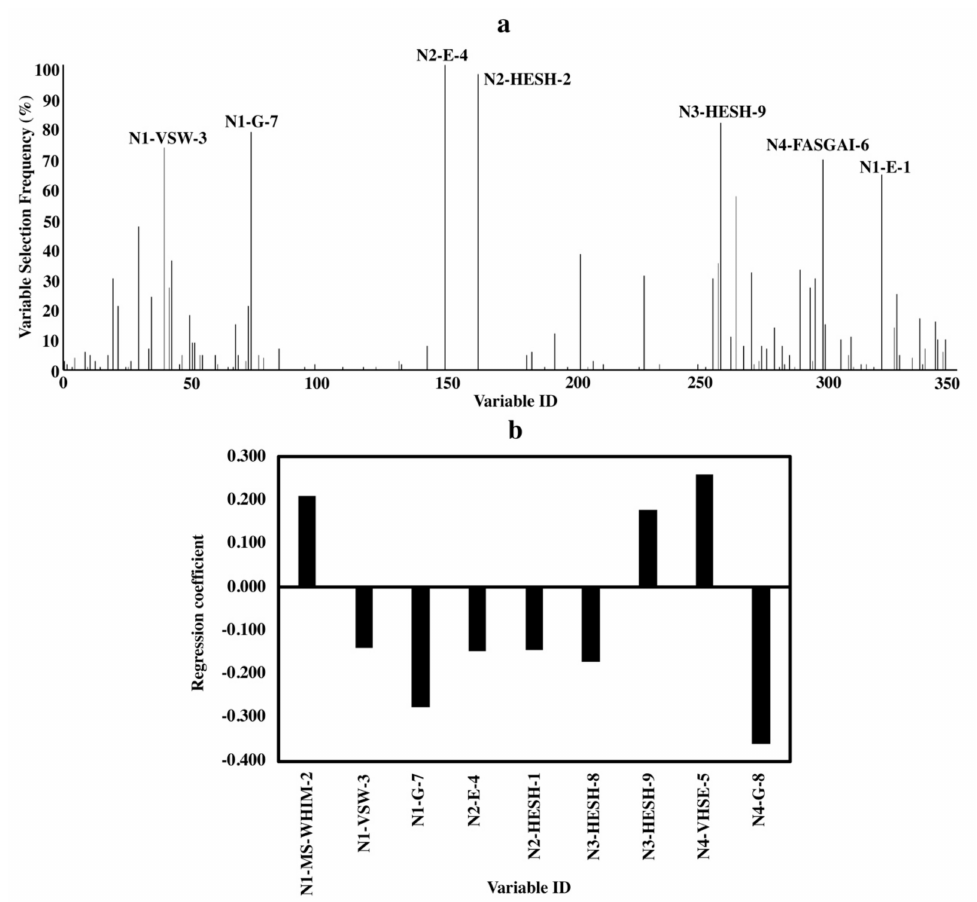
Figure 4. Variable importance of QSAR models for tetrapeptides. ( a ) Variable selecting frequencies of each variable from 100 BOSS runs; ( b ) standardized regression coe ffi cients of each variable based on the model with the smallest RMSECV from 100 BOSS